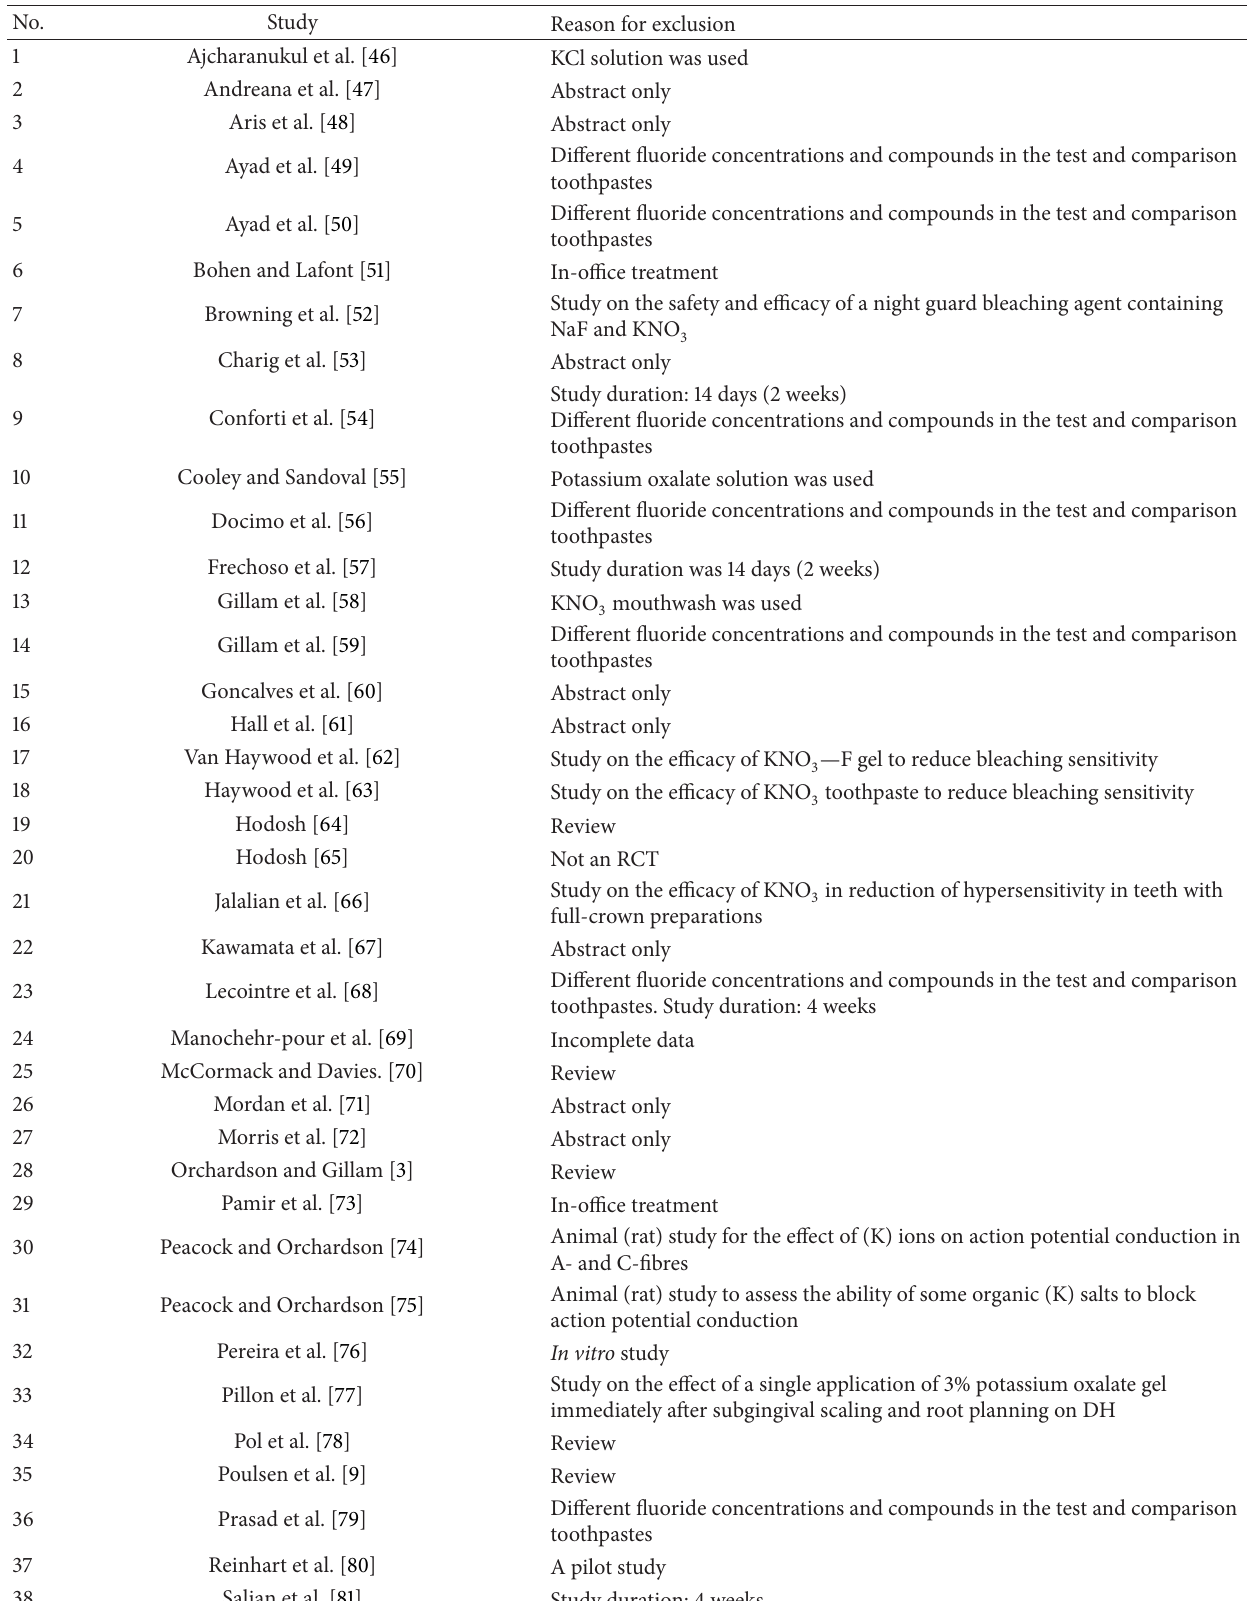
Table 2: Characteristics of potassium based toothpastes excluded studies